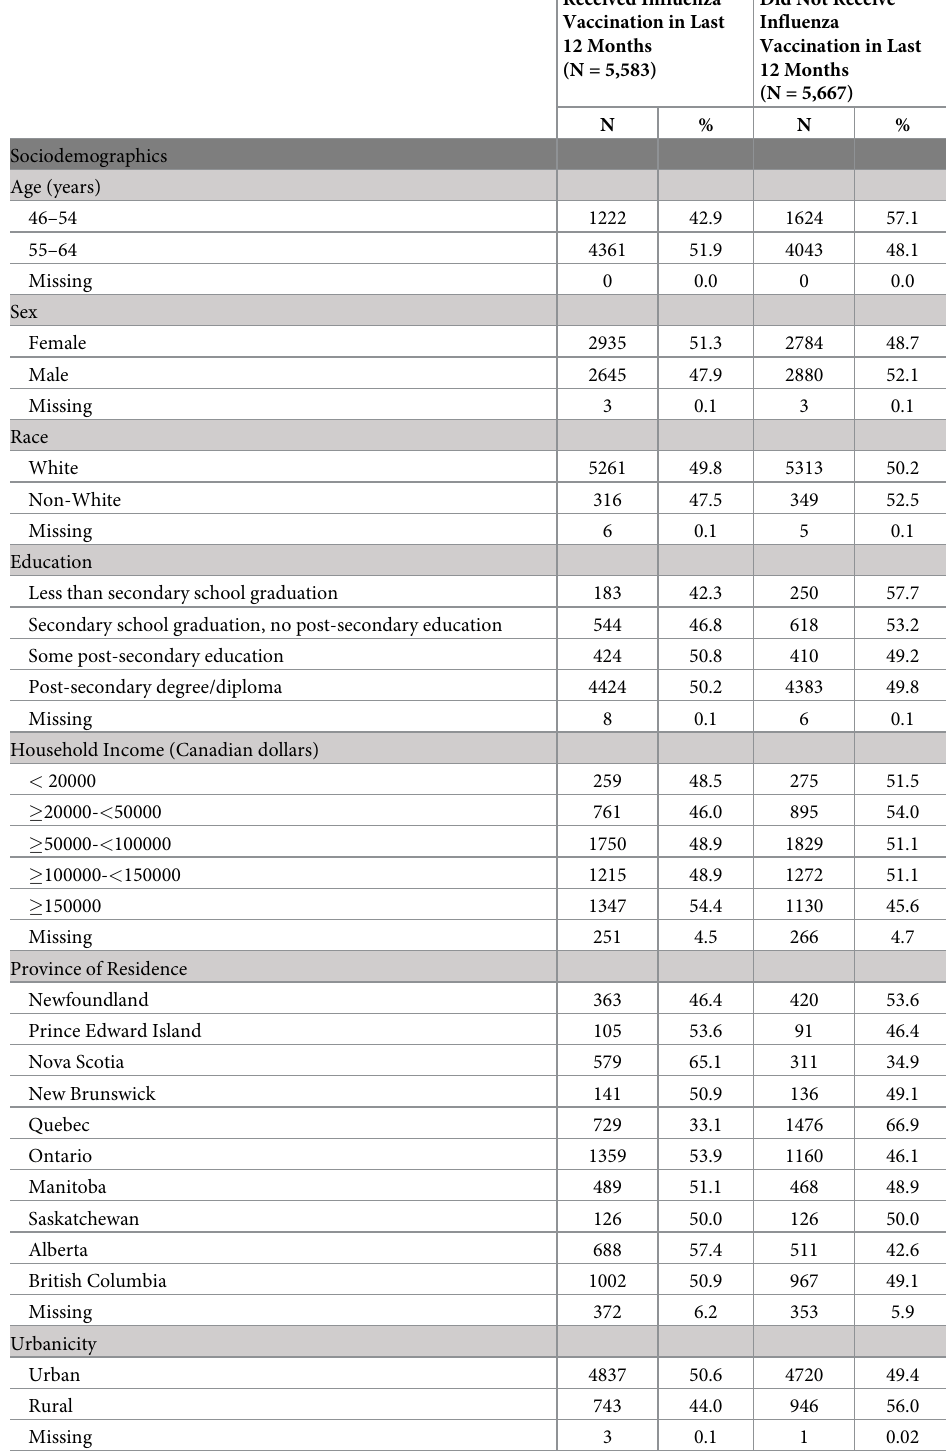
Table 2. Demographic characteristics by influenza vaccination status: Participants aged 46–64 years with at least one chronic medical condition (CMC) (N =